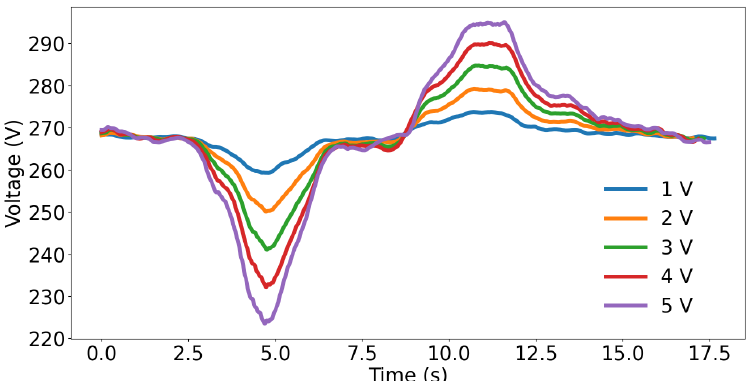
Figure 12. System voltage disturbances produced by different amplitudes of the feedforward signal for Cloud 2.